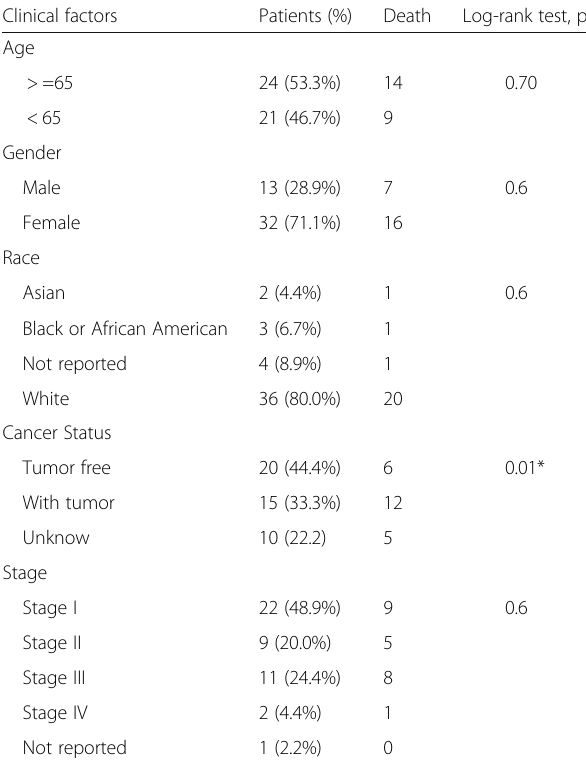
mutation Clinical